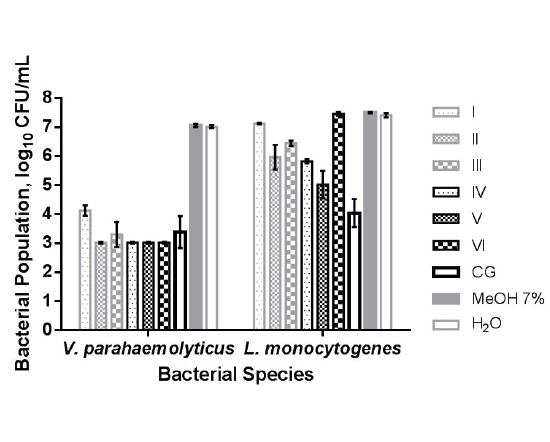
CFU/mL) of V. parahaemolyti- Figure 3: Logarithmic population (log 10 cus and L. monocytogenes in tryptic soy broth (TSB) with treatments of CG crude extract, CG HPLC fractions, 70% methanol, and sterile water. Column shows bacterial growth in samples. Error bar repre- sents standard deviation. CG: The crude Chinese gall extract; I – VI: the 6 HPLC fractions of